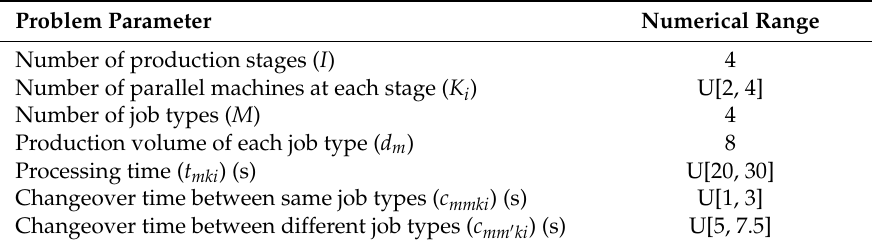
Table 2. Strategy parameter analysis experiment.